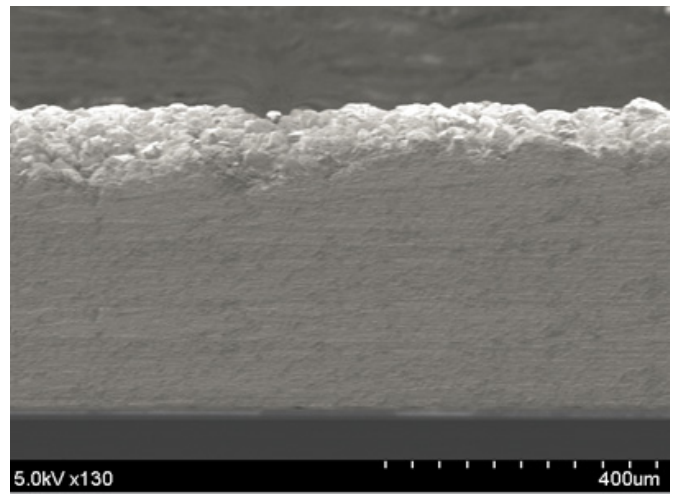
Figure 18. SEM image of the cross section of the 500- μ m-thick Sb 2 Te 3 film.